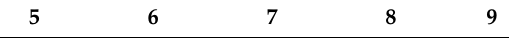
Table 1. Correlations of the Study